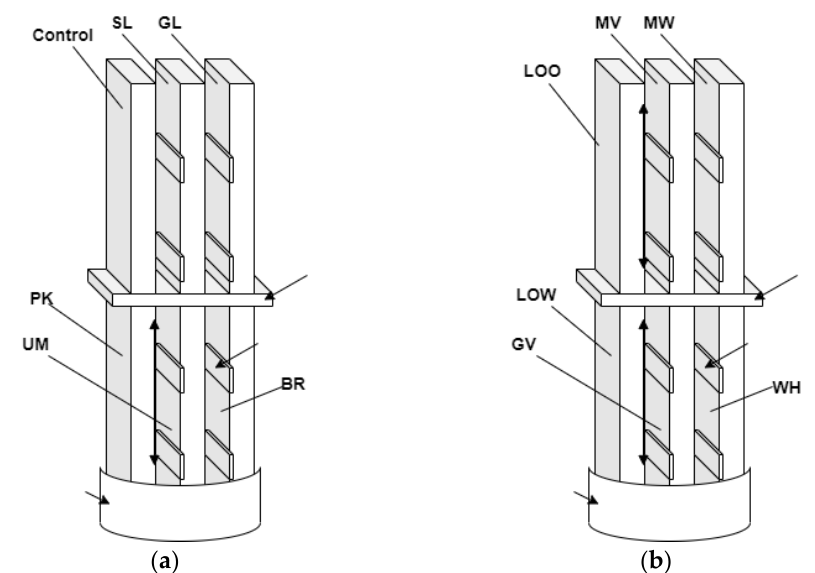
Figure 3. The sample arrangements of X-ray scanning: ( a ) sample series 1 consists of control, silver (SL), gold (GL), pink (PK), ultramarine (UM), and brown (BR); ( b ) sample series 2 consists of light- oak oil-based (LOO), matte varnish (MV), matte white (MW), light-oak water-based (LOW), glossy varnish (GV) and white (WH); long arrow indicating tape, two-way arrow indicating face-to-face coatings side.